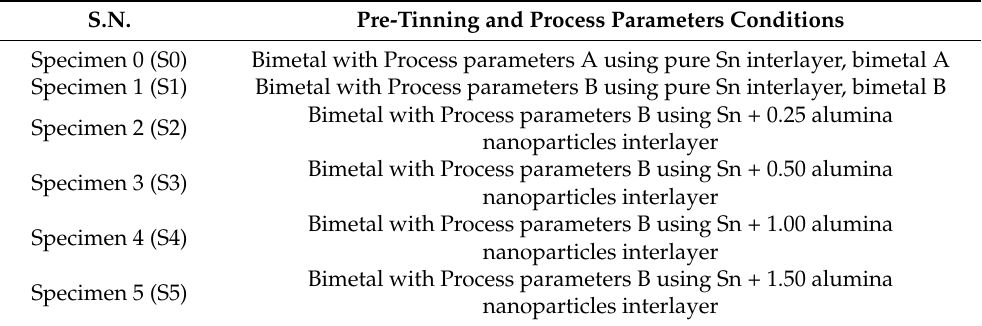
Table 3. Pre-tinning interlayer and processing conditions of the steel solid substrate and Al-bearing alloy for six